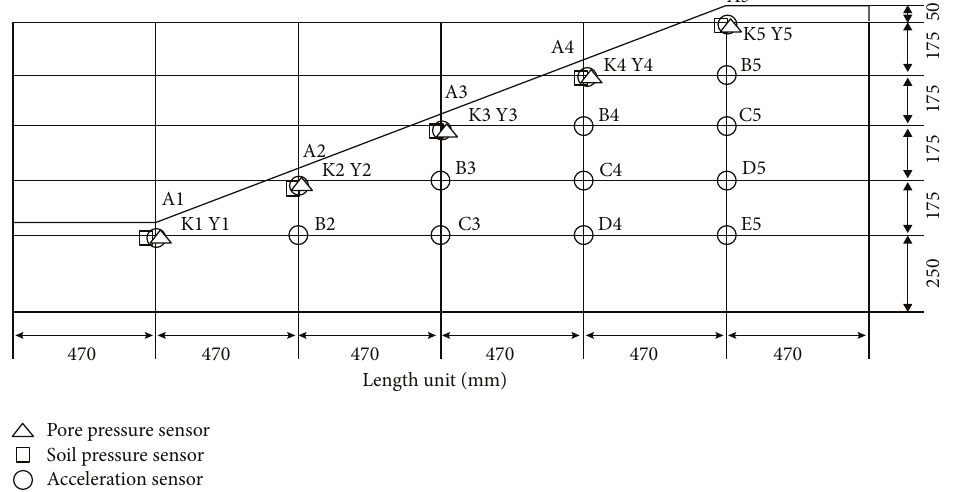
Figure 4: Slope model size and sensor